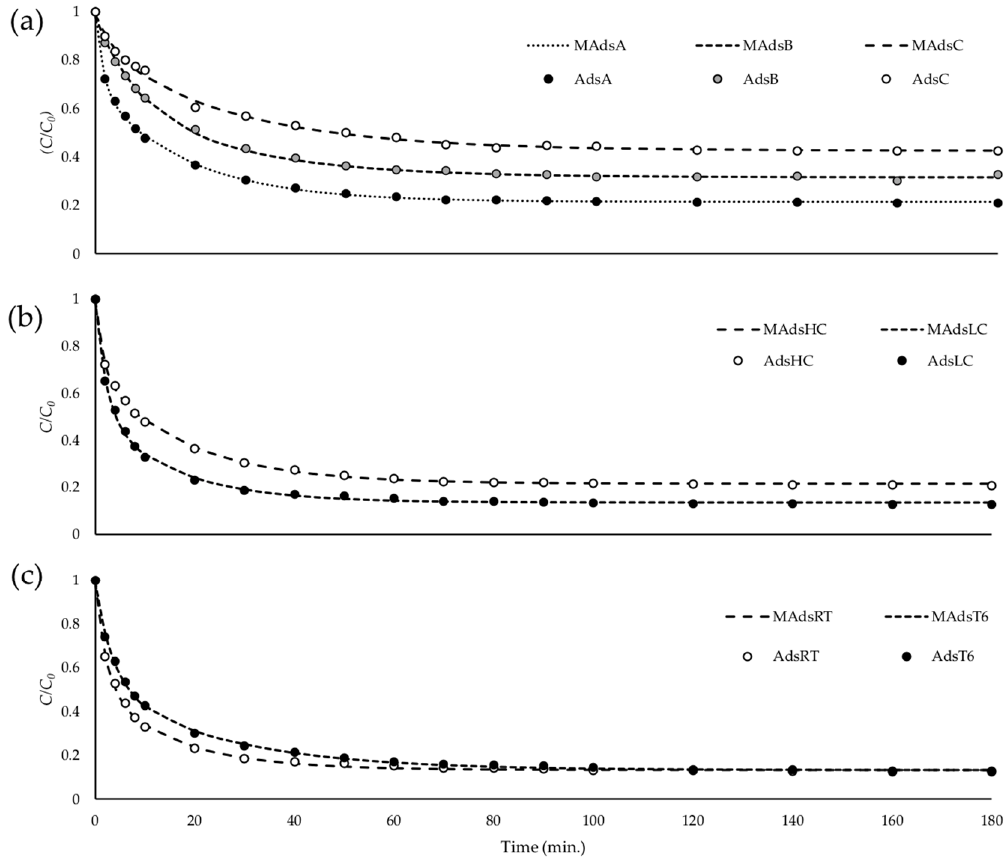
Figure 3. Adsorption kinetic isotherms for the assays performed to study the effect of ( a ) dispersion of FA and resin, ( b ) the initial concentration of FA, and ( c ) the temperature in the adsorption mixture. Parameters for adsorption isotherms equations were determined and compiled in Table 7. Based